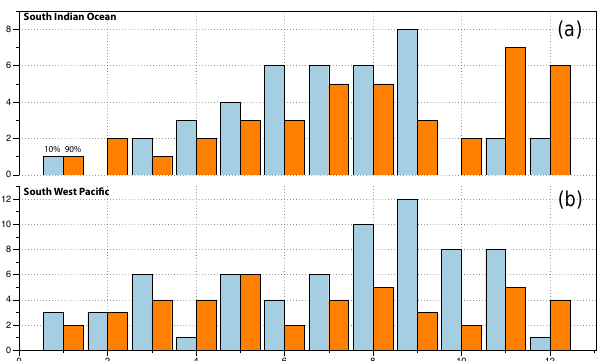
Figure 5. Distribution of 10th and 90th percentile deseasonalised surface pressure plotted for each month from 1979 to 2012 extracted from 20CR for the southern Indian (a) and southwestern Pacific (b) oceans. Note that anomalies occur throughout the